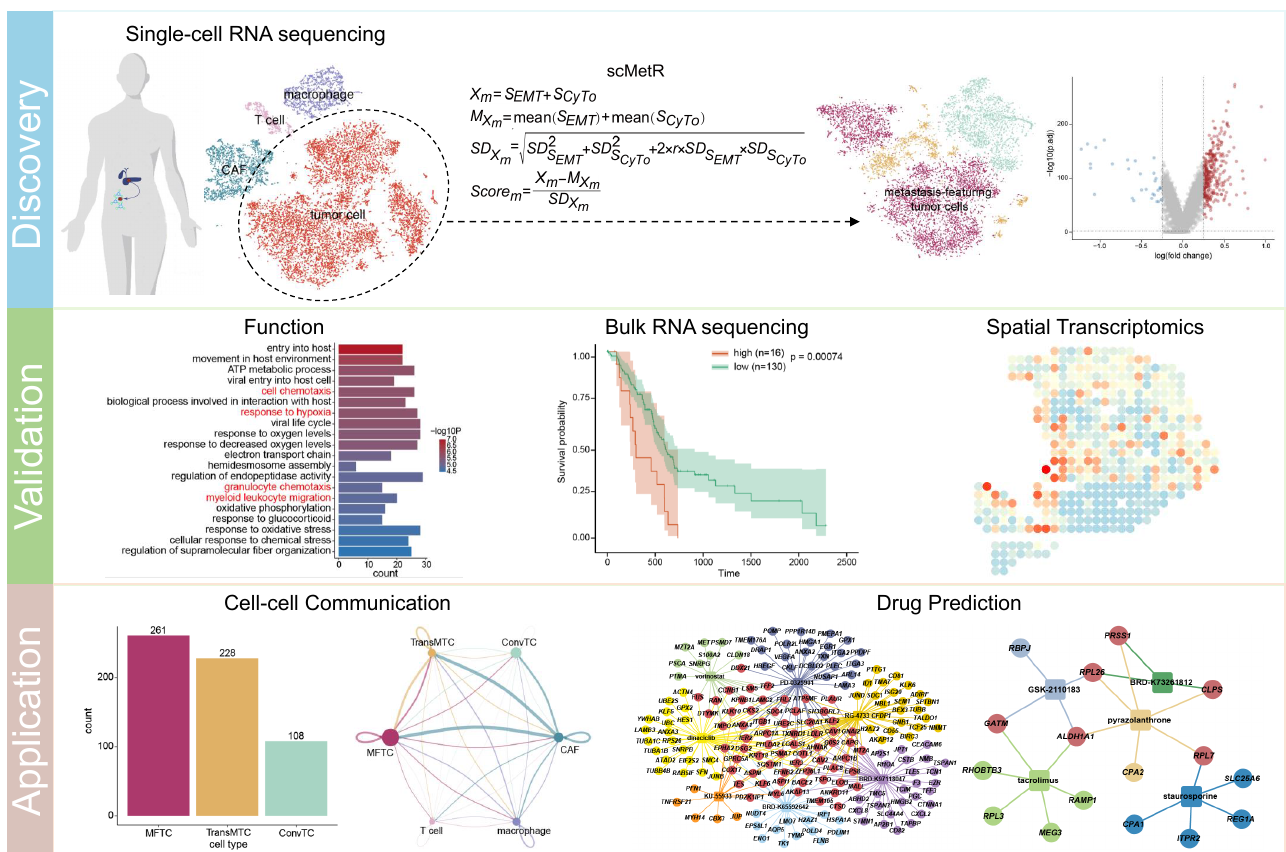
Figure 1. Analysis workflow for pancreatic ductal adenocarcinoma (PDAC)